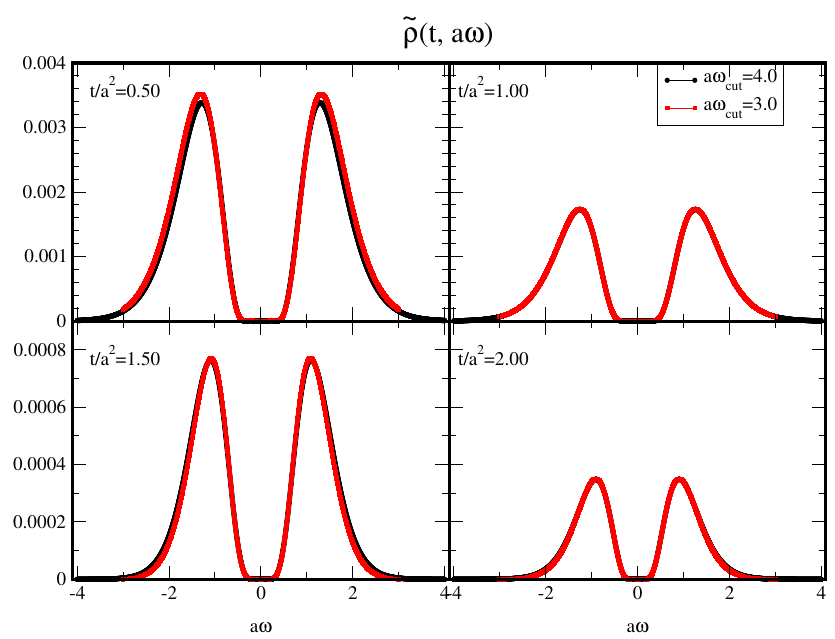
Figure 8 . The ! cut dependence of the spectral function for several (cid:13)ow-time data.